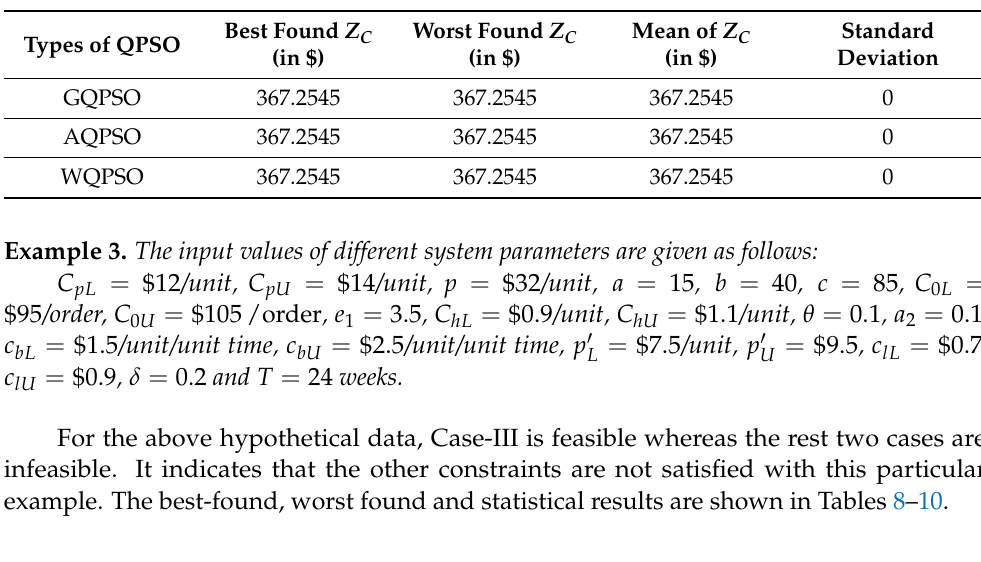
Table 7. Statistical analysis for different types of QPSO for Case-II of Example